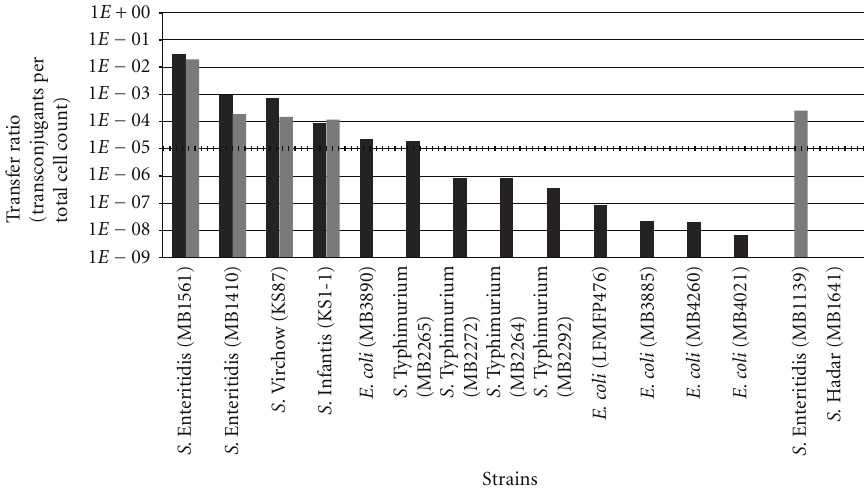
Figure 1: Transfer ratio, expressed as number of transconjugants per total cell count, determined by plating (black bars) and by flow cytometry (grey bars) for the 15 recipient strains. The dashed line represents the detection limit of flow